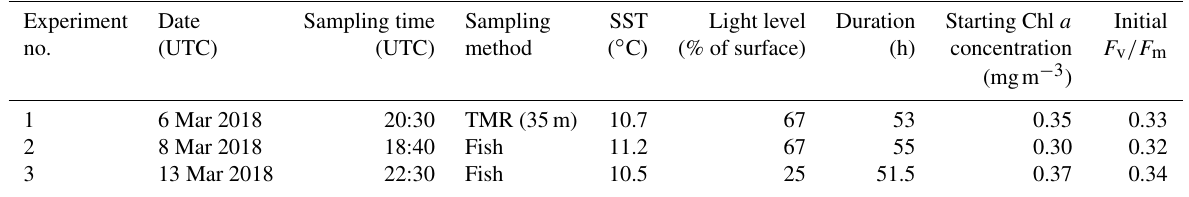
Table 1. Details of incubation experiments.